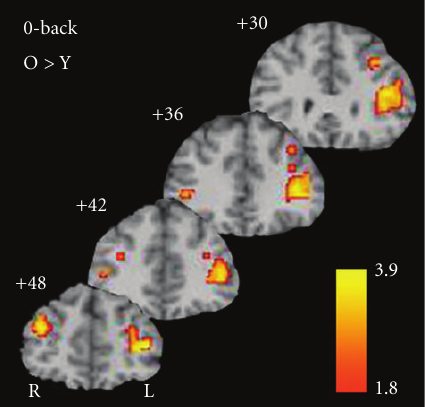
Figure 5: Regions of greater activity for older compared to younger adults on the 0-back. Areas exceeding P corr < 0 . 05 are included.